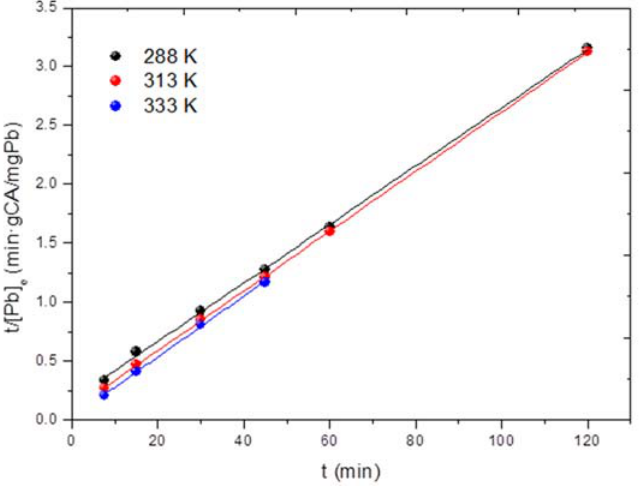
with constant kinetic rates of 4 × 10 − 3 ( R 2 = 0.9993), 8 × 10 − 3 ( R 2 = 0.9999), and 3 × 10 − 2 ( R 2 = 0.9992) g·mg − 1 ·min − 1 at 288, 313, and 333 K, respectively. In Equation (2), t is the time elapsed; [Pb] t and [Pb] e are the lead concentrations on the AC at that time and at equilibrium, respectively; and k 2 is the rate constant.